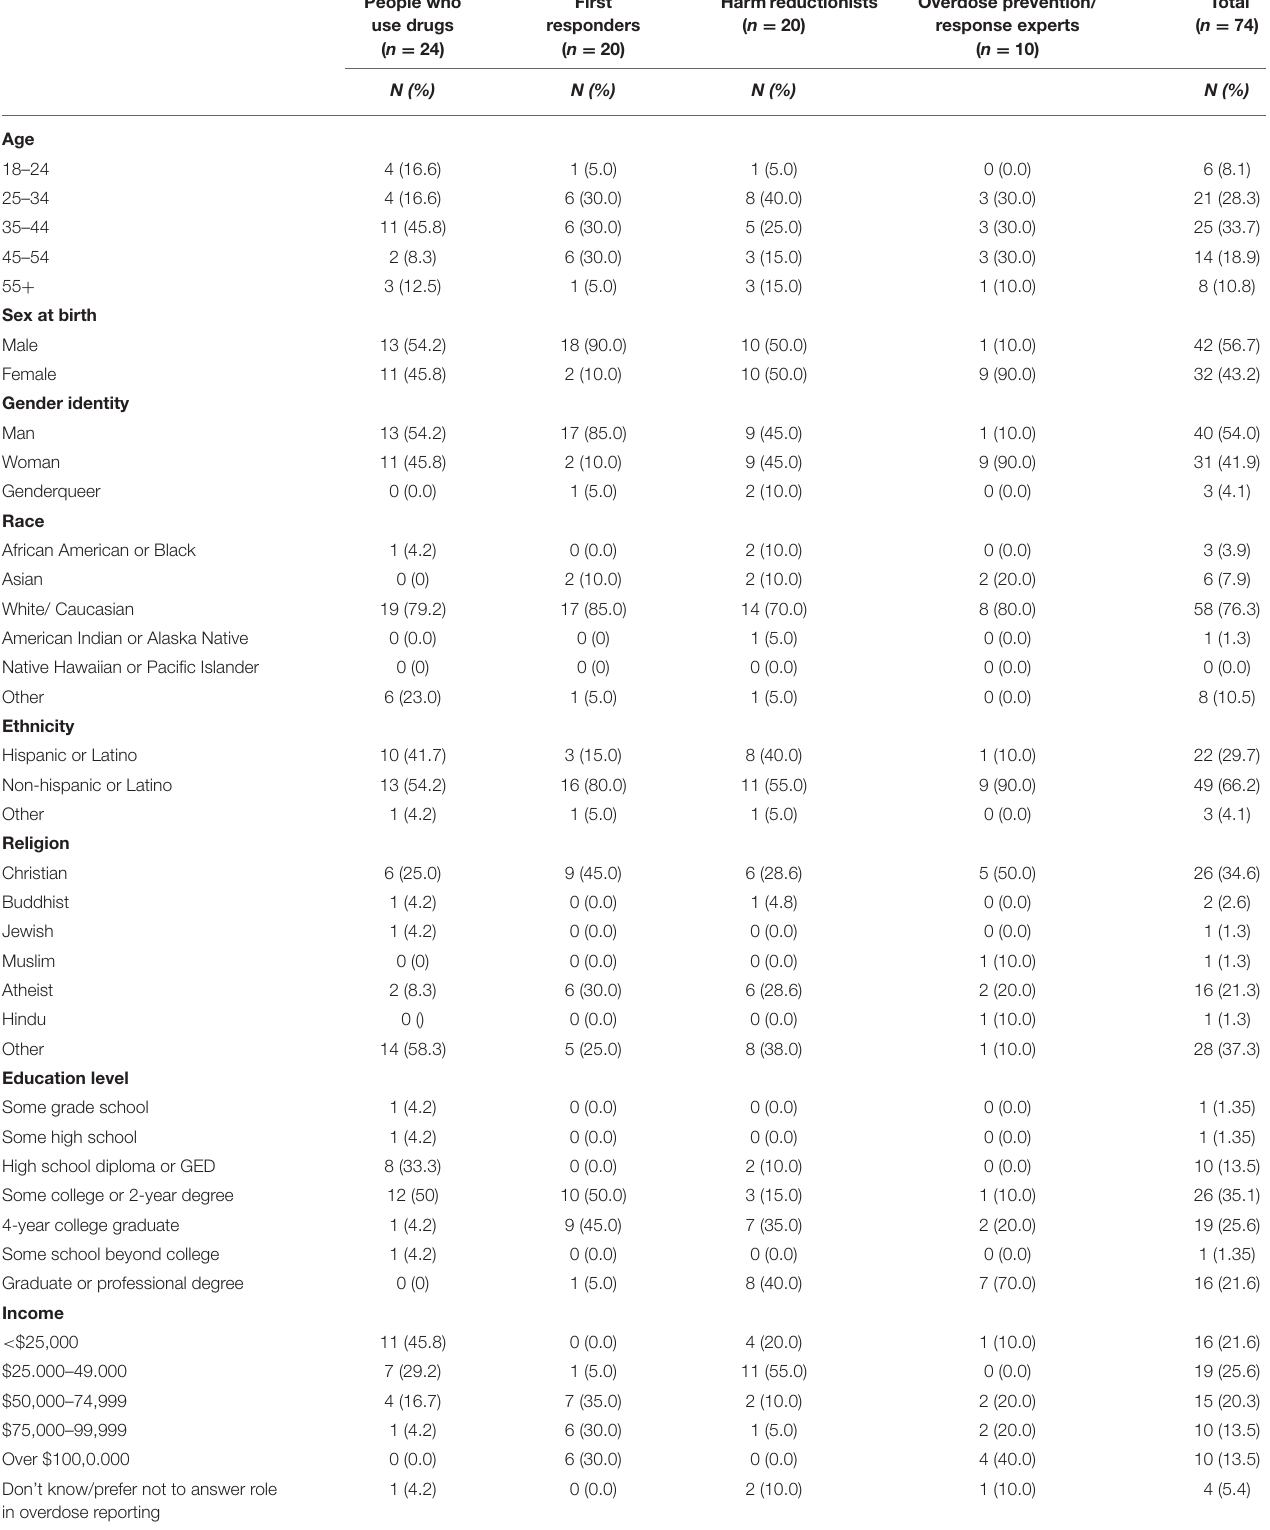
TABLE 2 | Participant characteristics ( N =